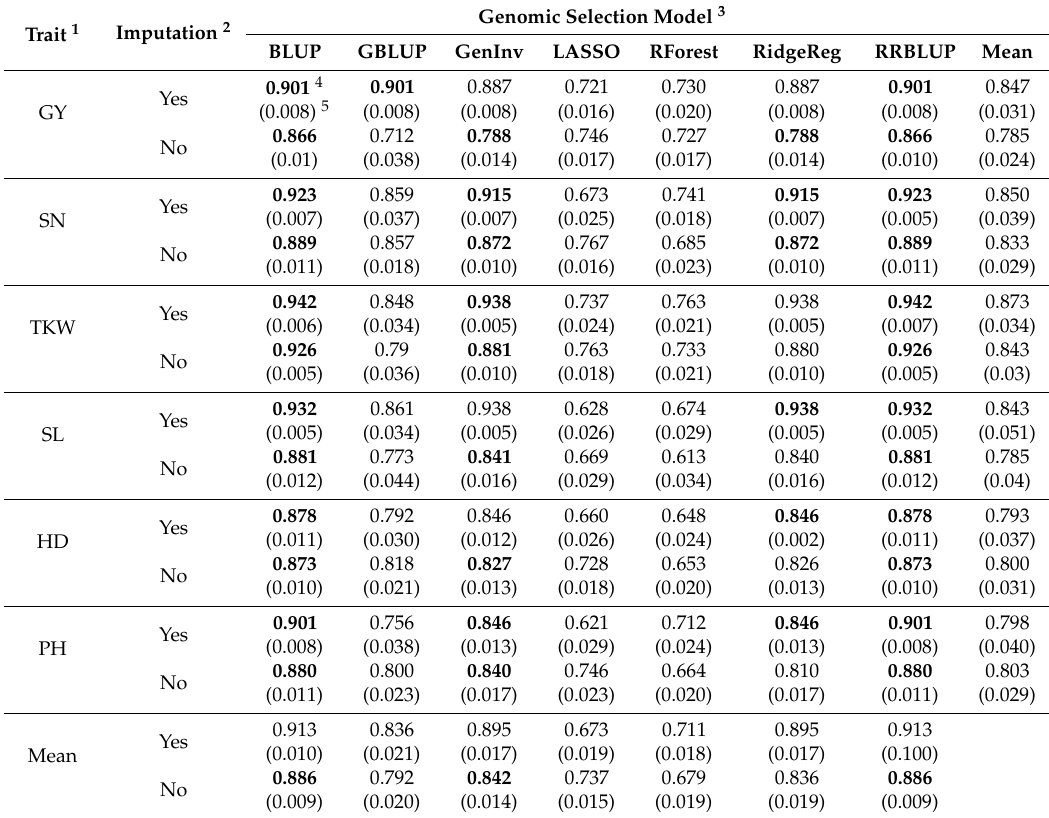
Table 6. Prediction accuracy for yield and yield-related traits using significant markers detected by genome-wide association studies (GWAS). Both imputed and non-imputed scenarios were considered. The QC to keep markers with missing rate levels < 40% and minor allele frequency (MAF) > 5% was used as an